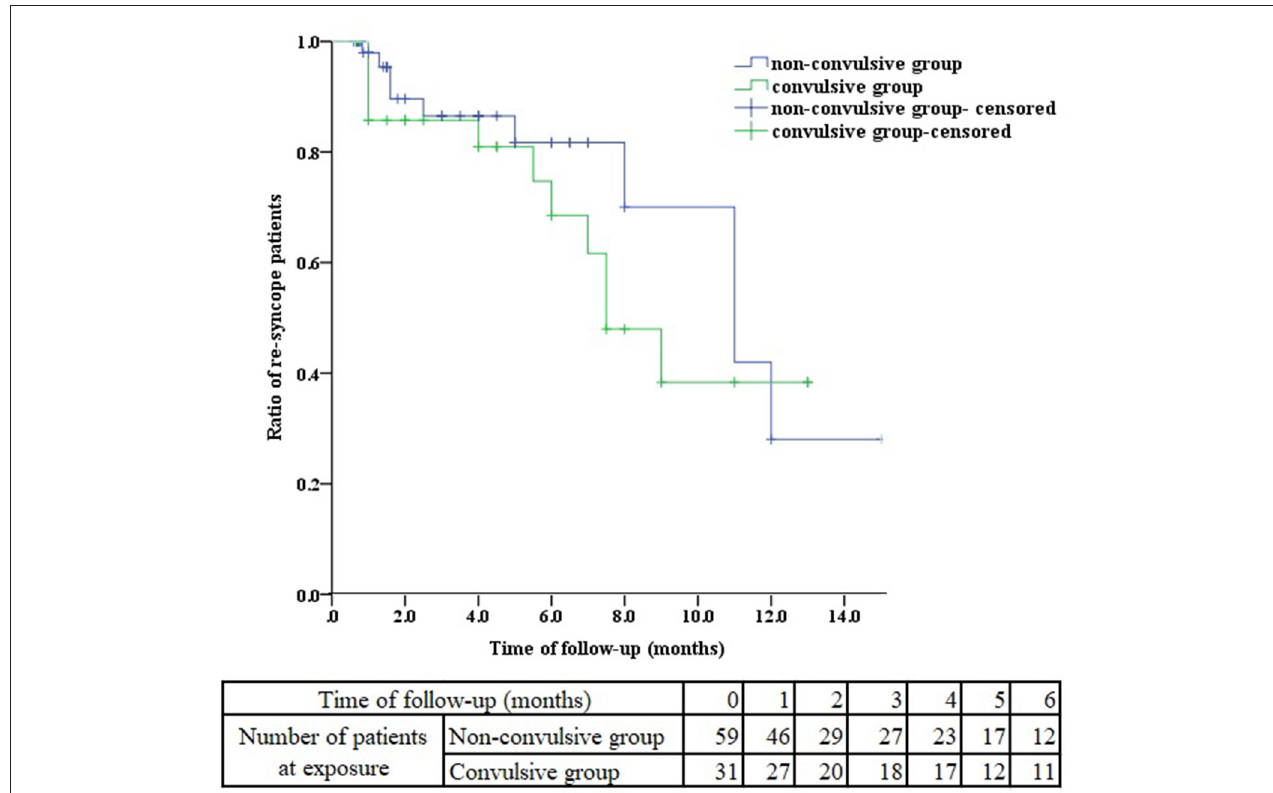
FIGURE 2 | Kaplan-Meier curve analysis of the ratio of re-syncope patients between non-convulsive and convulsive groups.